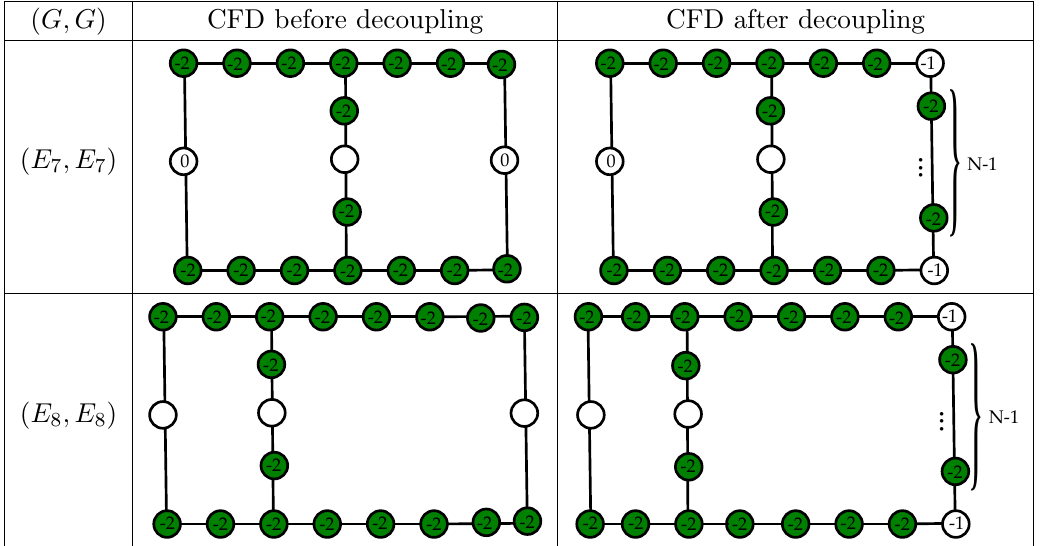
Table 6. CFDs for non-minimal N ( E 7 ; E 7 ) and ( E 8 ; E 8 ) conformal matter. The left hand picture shows the CFD before decoupling, the right hand one